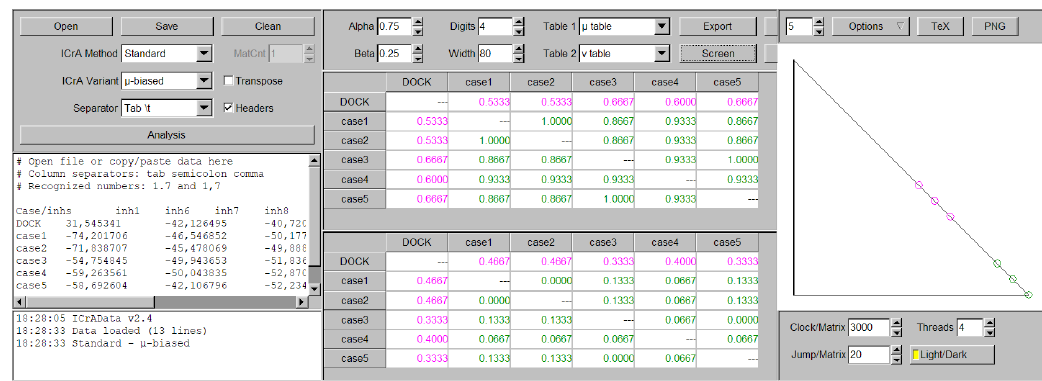
Fig. 3. Results from ICrA applied to ER α